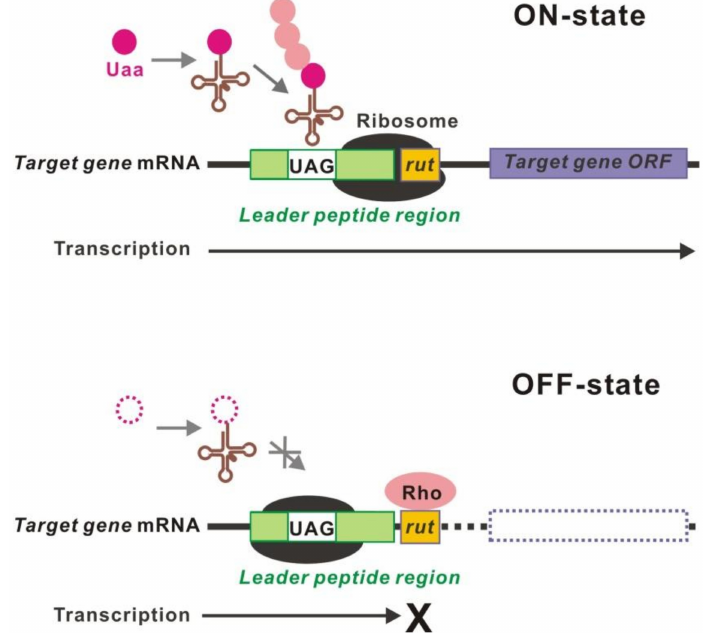
Figure 8. Uaa transcriptional switch. The transcription of the target gene open reading frame (ORF) requires the translation of a leader peptide beyond the inserted UAG. In the absence of the Uaa, translation of a leader peptide is interrupted, resulting in transcriptional termination at the unmasked rut